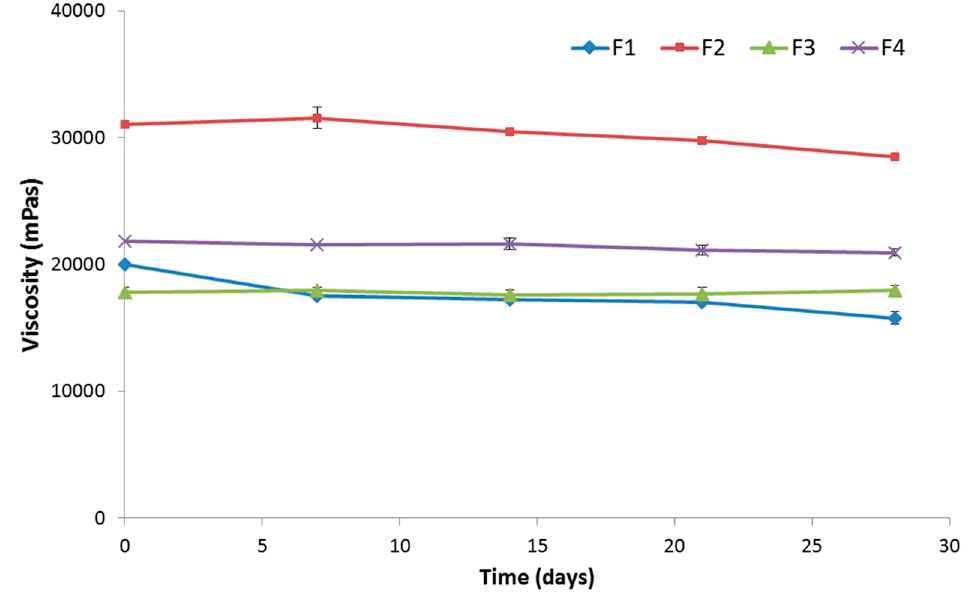
Figure 6. Viscosity of hydrogels F1–F4 in response to 4-week storage at 4 °C measured at shear rate 6 s − 1 at 25 °C (mean ± S.D.; n = 3).